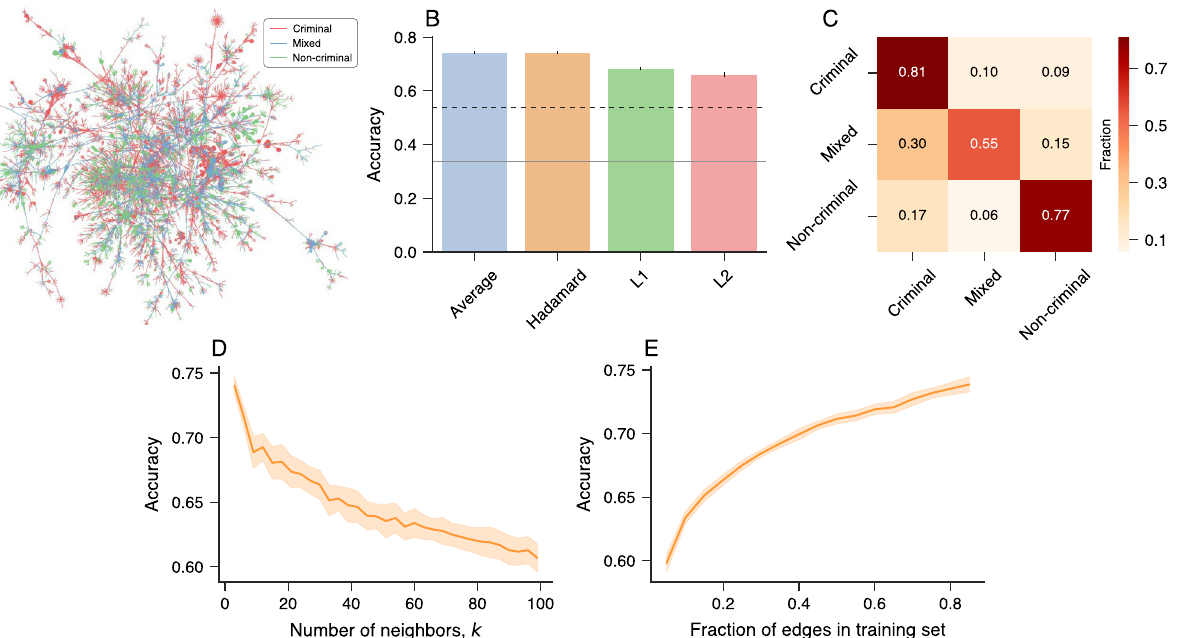
Figure 2. Determining the types of association in criminal networks. ( A ) Visualization of the three different types of association among people in the giant component of the Brazilian criminal intelligence network. Edges in red, blue, and green represent criminal relationships, mixed relationships, and non-criminal relationships, respectively. ( B ) Accuracy of k -nearest neighbor classifiers ( k NN with k = 1 ) trained with node2vec representations and different binary operators. The bars stand for the average accuracy estimated from test sets over ten realizations of the embedding and training processes (error bars represent one standard deviation). The gray continuous line represents the accuracy of a dummy classifier that makes random predictions based on the relative frequency of each type of association in the training set, and the black dashed line indicates the accuracy of a dummy classifier that always predicts the most common type of association in the training set (criminal edge). ( C ) Confusion matrix associated with the k NN classifier predictions (with k = 1 and the Hadamard operator) for the type of criminal associations in the test sets (rows indicate true labels). ( D ) Average accuracy in the test sets as a function of the number of neighbors ( k ) in the k NN classifiers. ( E ) Average accuracy in the test sets as a function of the fraction of edges in the training sets. In the last two panels, the solid lines indicate the average accuracy, and the shaded regions stand for one standard deviation band estimated over ten realizations of the embedding and training processes with the Hadamard